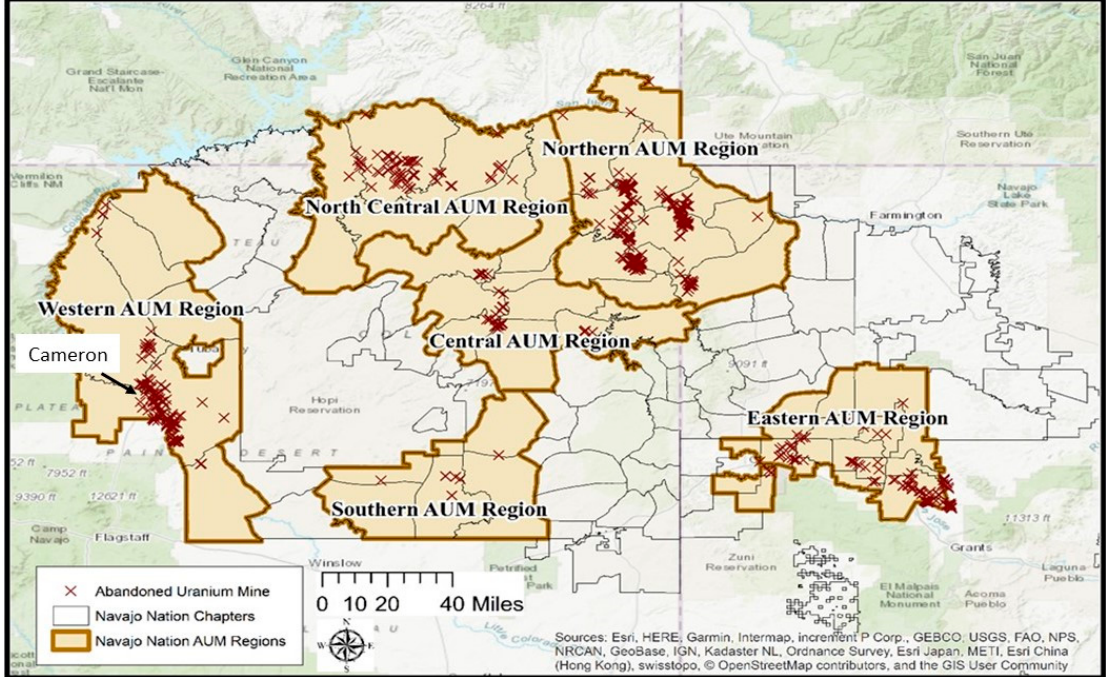
Figure 1. Map of the Navajo Nation illustrating the abandoned uranium mine locations.